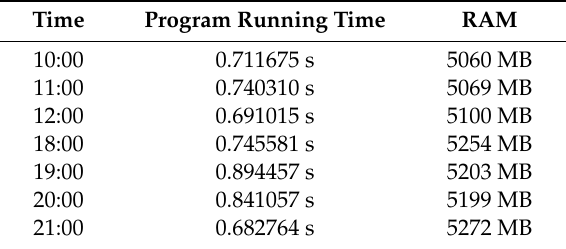
Table 10. Upper model program run time and required RAM.